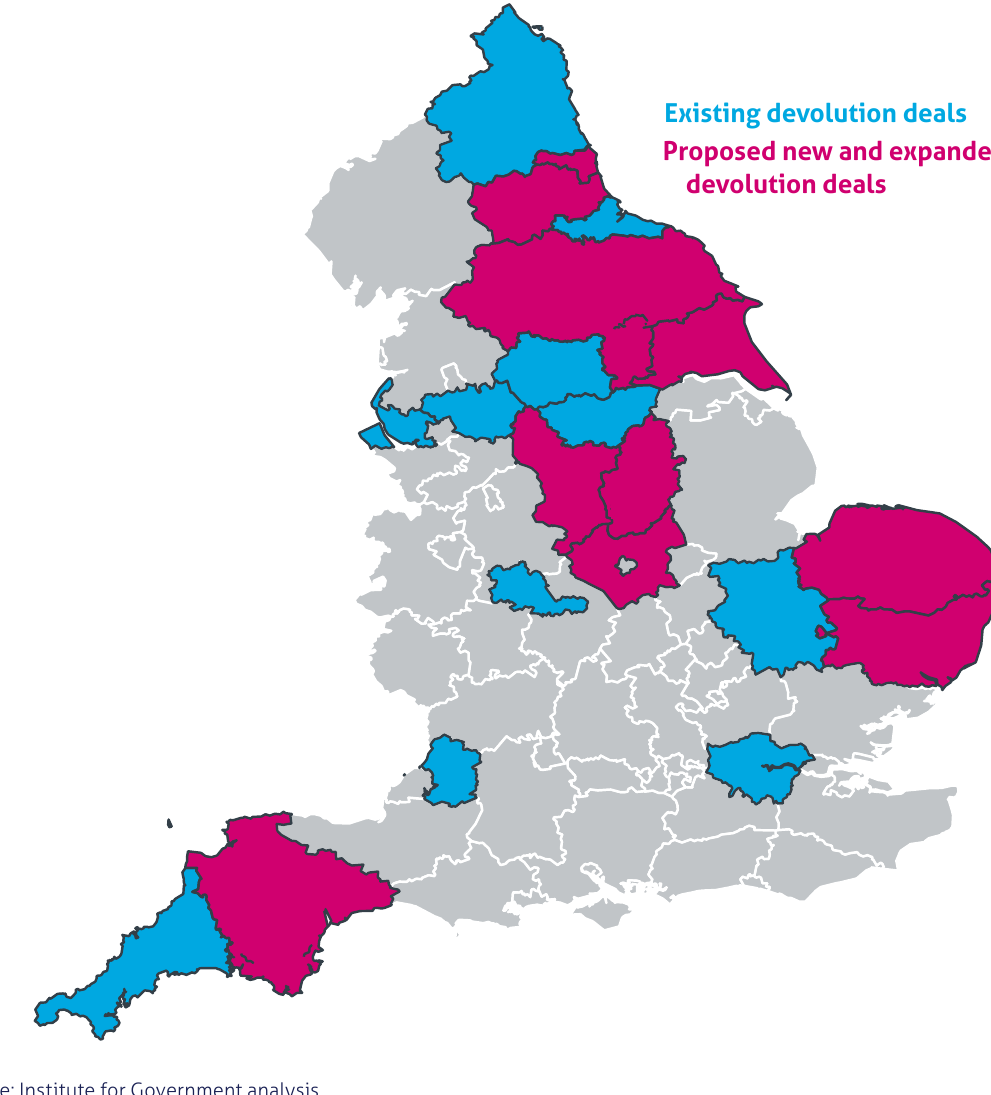
Figure 4 Existing and proposed devolution deals by area, England